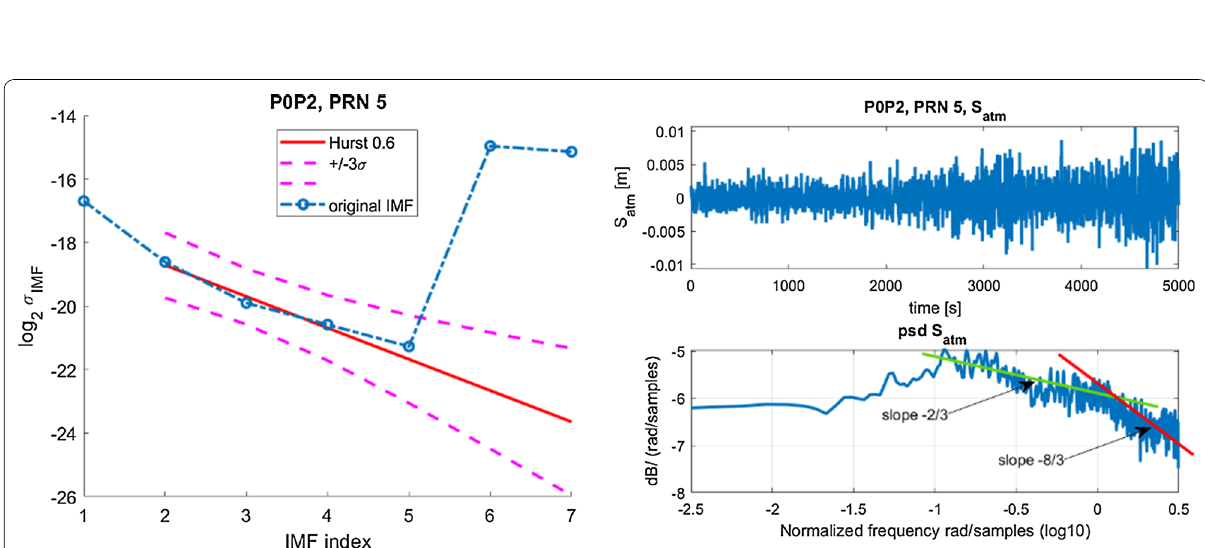
Fig. 9 Processing steps to identify atmospheric noise. Left: log 2 variances of the IMF versus the IMF index. The red straight line corresponds to the fGn with H 0.6, i.e. the best fit for IMF 2 − 4 . The magenta line defines the domain of exclusion. The discrete blue dotted line represents the log 2 = variance for the original observations. Right: top: the filtered time series as combination of the IMFs kept and at the bottom, its corresponding psd with the expected atmospheric slopes 2/3 and − −